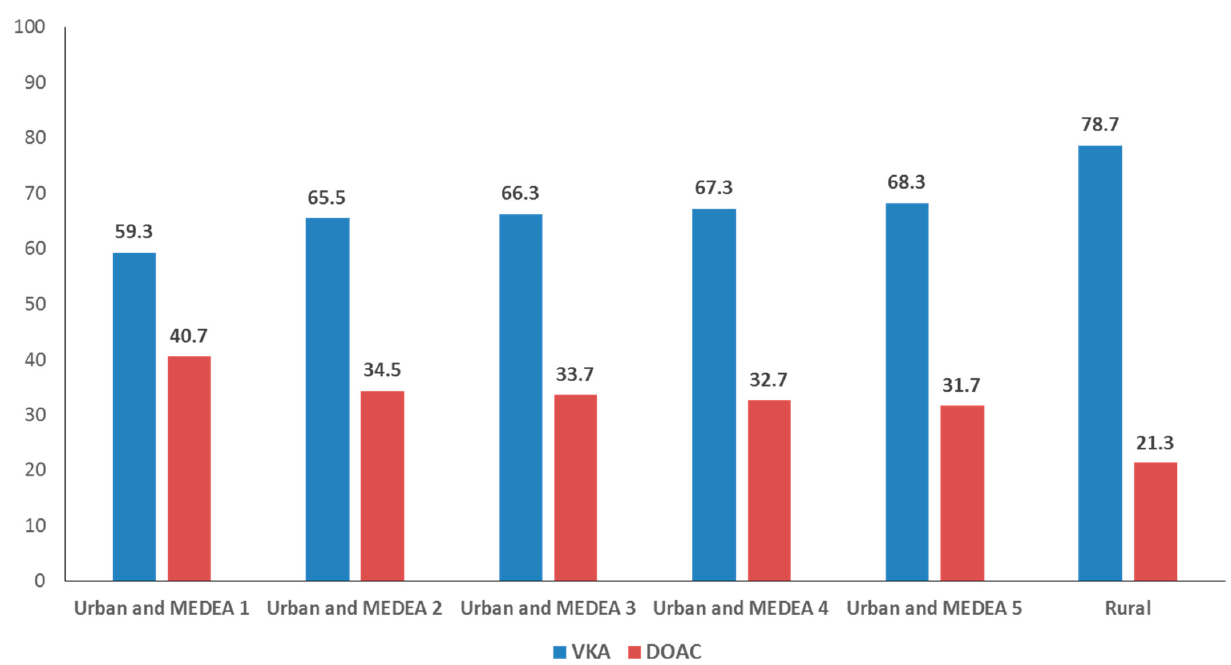
Figure 1. Proportional distribution of prescriptions for vitamin K antagonists (VKA) versus direct oral coagulants (DOAC) according to the deprivation index of urban Primary Care centers (high MEDEA score = more deprivation) or rurality.